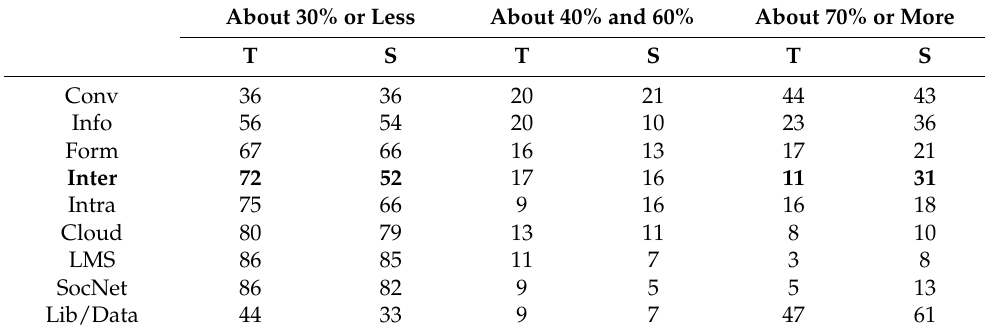
Table 5. Ways of finding information in the area of scientific activities regarding the field of science. About 30% or